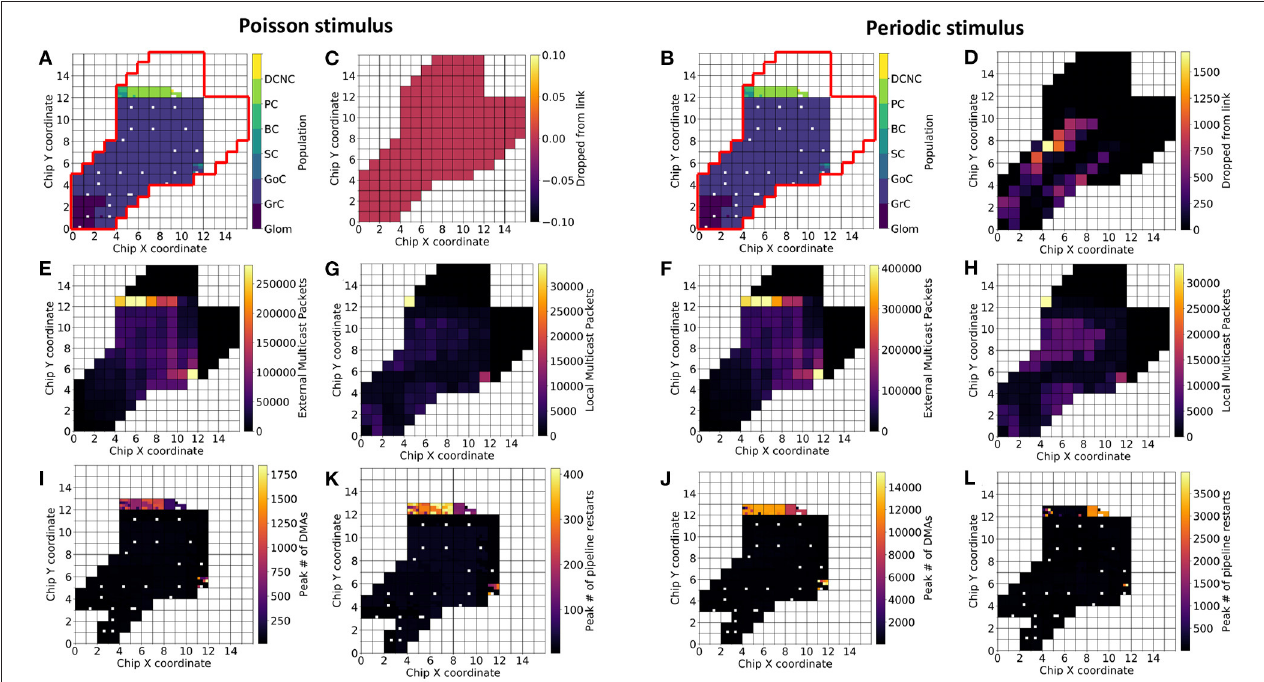
FIGURE 7 | Population placement and statistics on three-board machines. The Cerebellum model requires ∼ 1,583 cores for the current number of neurons per core (101 chips spread over three boards). For identical partitioning and placements with Poisson (A) and periodic (B) stimuli (red outline delimits the full extent of chips on the three-board system), the figure shows number of packets the routers dropped (C,D) , total number of external packets (E,F) , total number of local packets (G,H) , the maximum number of direct memory accesses (DMAs) in a timestep (I,J) , and the maximum number of processing pipeline restarts (K,L) . White squares within the 3-machine system used here correspond either to cores not active during the current simulation or cores that are permanently deactivated due to manufacture